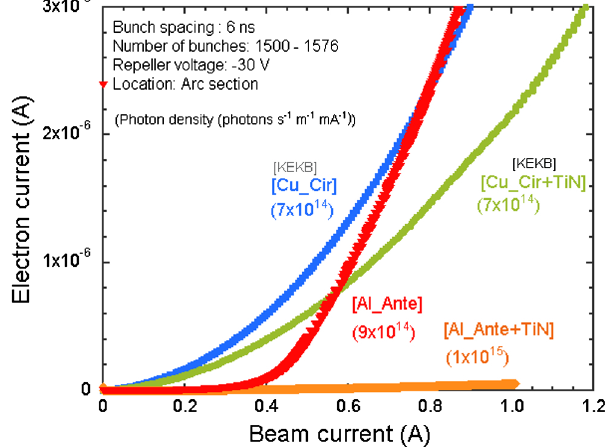
FIG. 9. Measured electron currents for four types of beam pipes for bunch fill patterns consisting of one train of 1500 – 1576 bunches with 6 ns bunch spacing. Here, [Cu Cir þ TiN] and [Cu Cir] present the data obtained from Cu beam pipes having circular cross sections with and without TiN coating, respectively, which were measured in KEKB. [Al Ante þ TiN] and [Al_Ante] denote the data from Al-alloy beam pipes having antechambers with and without TiN coating, respectively. Note that the inte- grated beam doses achieved when the data of [Cu Cir þ TiN], [Cu_Cir], [Al Ante þ TiN] and [Al Ante] were measured were approximately 3200, 3900, 760, and 760 Ah,